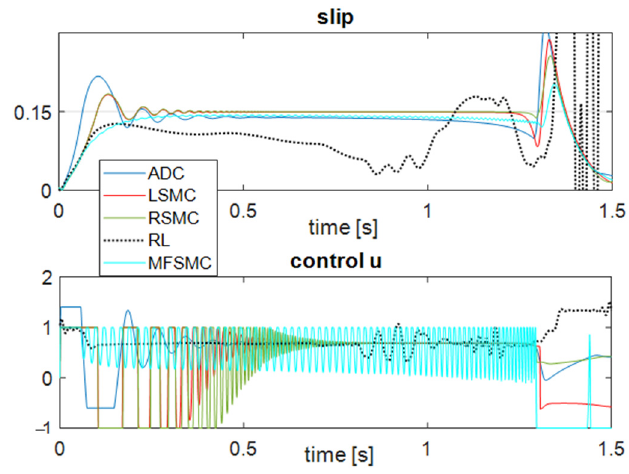
Figure 6. The slip control results obtained with the Lyapunov-based sliding mode controller (LSMC), RSMC, active dynamic controller (ADC), reinforcement learning (RL) and model-free sliding-mode controller (MFSMC) structures.